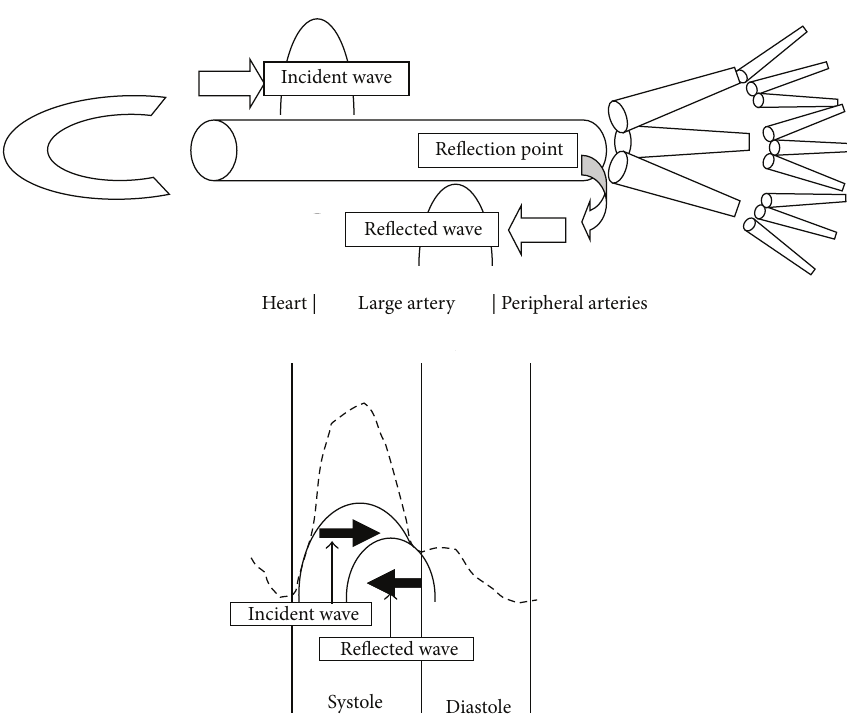
Figure 1: Schema of propagation of the incident pulse wave, reflected pulse wave, and their interaction in the arterial tree.